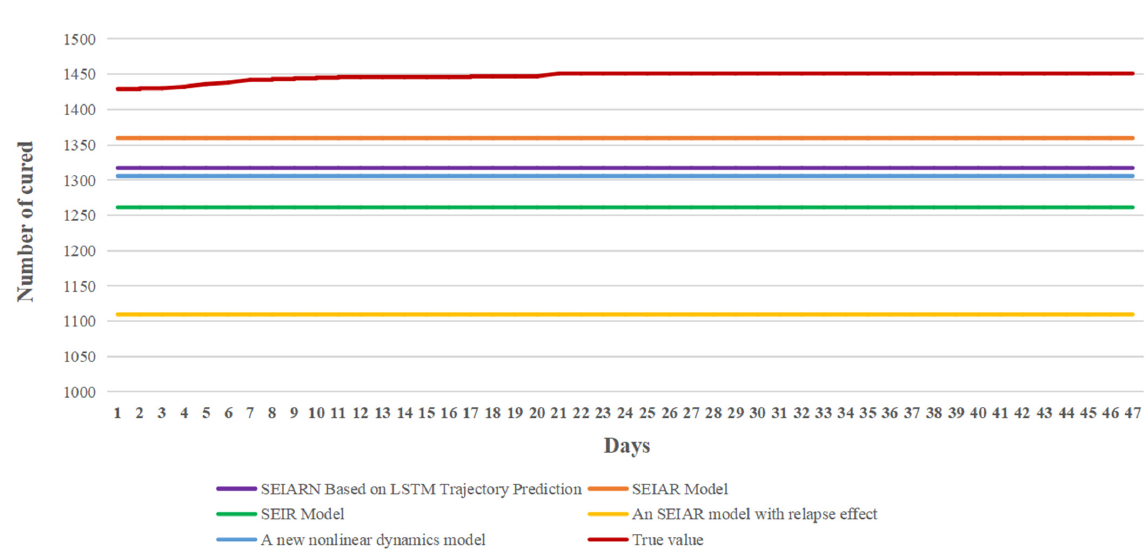
Figure 20. Comparison chart of the number of deaths.